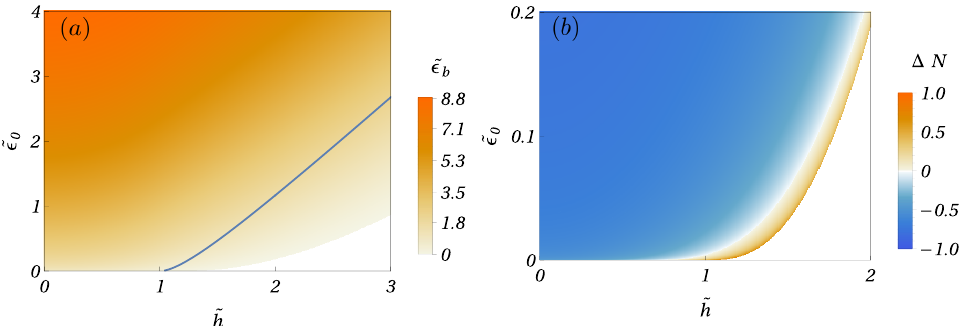
[ panel (a) ] and bound-state triplet char- Figure 6: Dimensionless binding energy ˜ ε b (cid:80) − N [ panel (b) ] of 2D-fermion dimers with zero N acter quantified by ∆ N ≡ 1 M 00 M center-of-mass momentum formed in the presence of 1D-type spin-orbit coupling and Zeeman splitting. These plots can be compared with corresponding results for the 2D-type spin-orbit couplings shown in Figs. 1(a) and 3(a), respectively. The solid blue curve in panel (a) is the critical-boundary line (51) delimiting the region where a bound state exists for 2D-type spin-orbit coupling. Evidently, the existence region for bound states formed with asymmetric spin-orbit coupling extends well beyond.